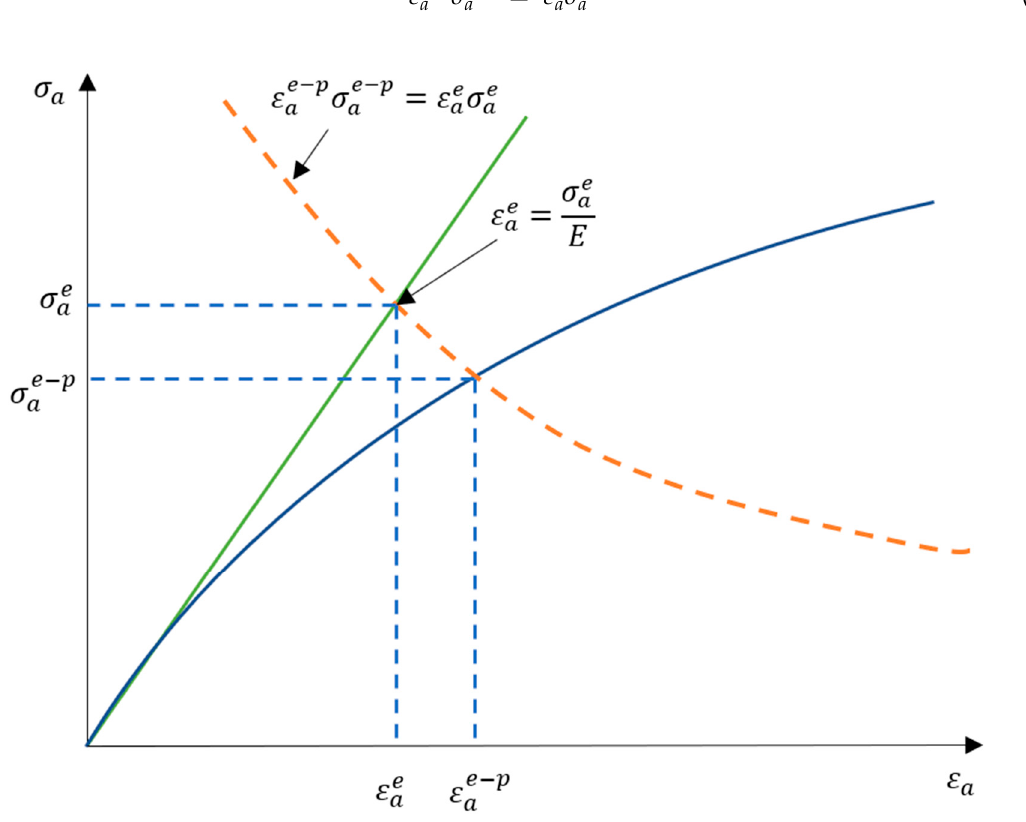
Figure10. Neuberhyperbolatogetherwiththelinearelastoplasticmodel(Hooke’slaw)anddeformation Figure 10. Neuber hyperbola together with the linear elastoplastic model (Hooke’s law) and curve used in the derivation of the deformation curve used in the derivation of the model.